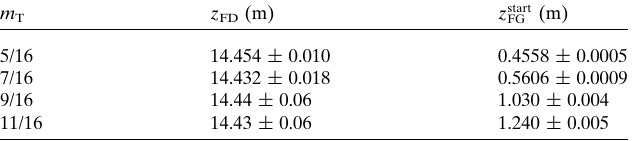
Table 1 Overview of the distances z FD and z start inverse grating magnification values.